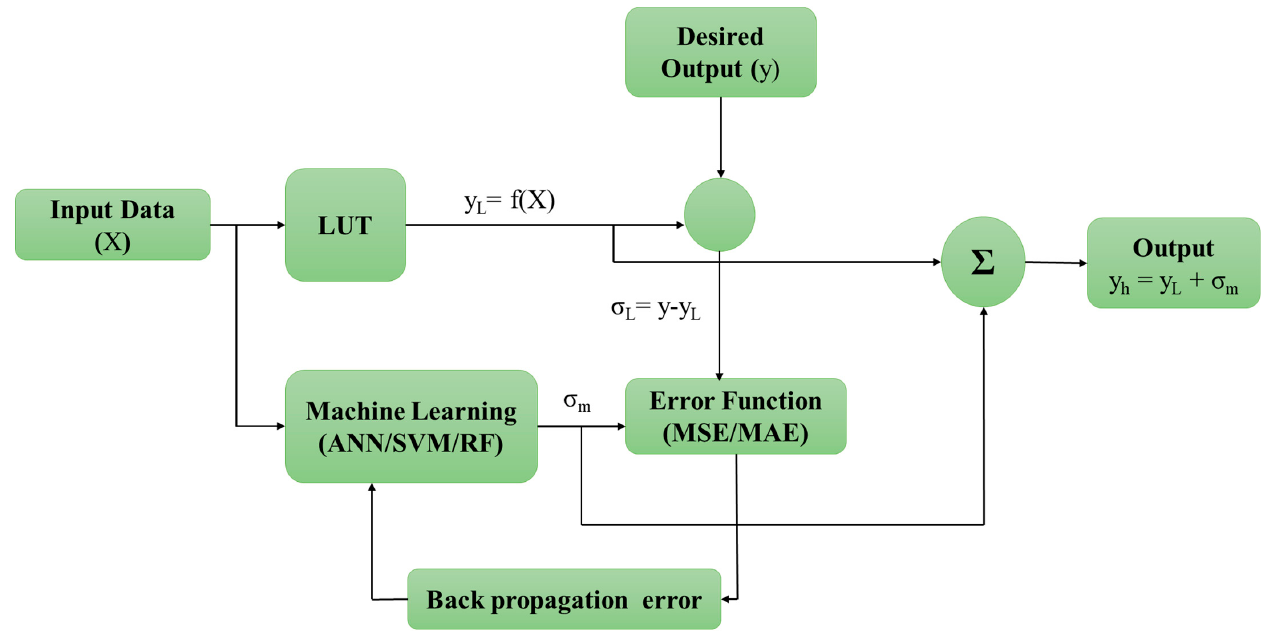
Figure 4. Flow diagram of hybrid framework .